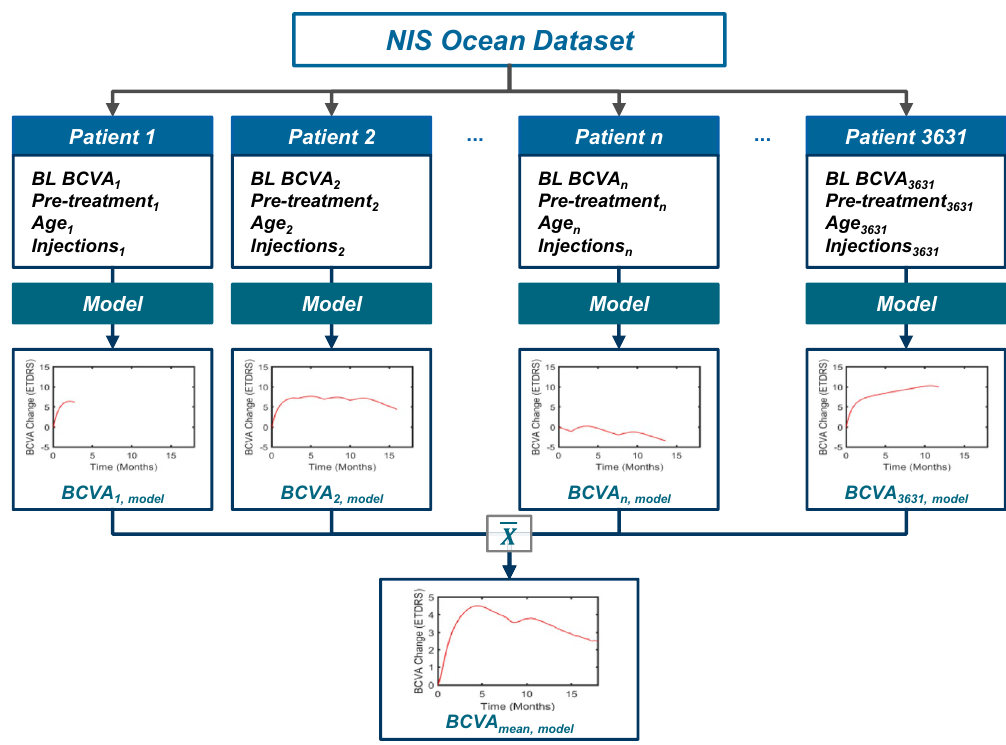
Figure 1. Development of visual acuity prediction model based on individual baseline characteristics (BL BCVA, age and pre-treatment status) and the time and dose of anti-VEGF intravitreal injections. The model was trained using real-world data from the non-interventional study OCEAN. BCVA = best corrected visual acuity; BL = baseline; VEGF = Vascular Endothelial Growth